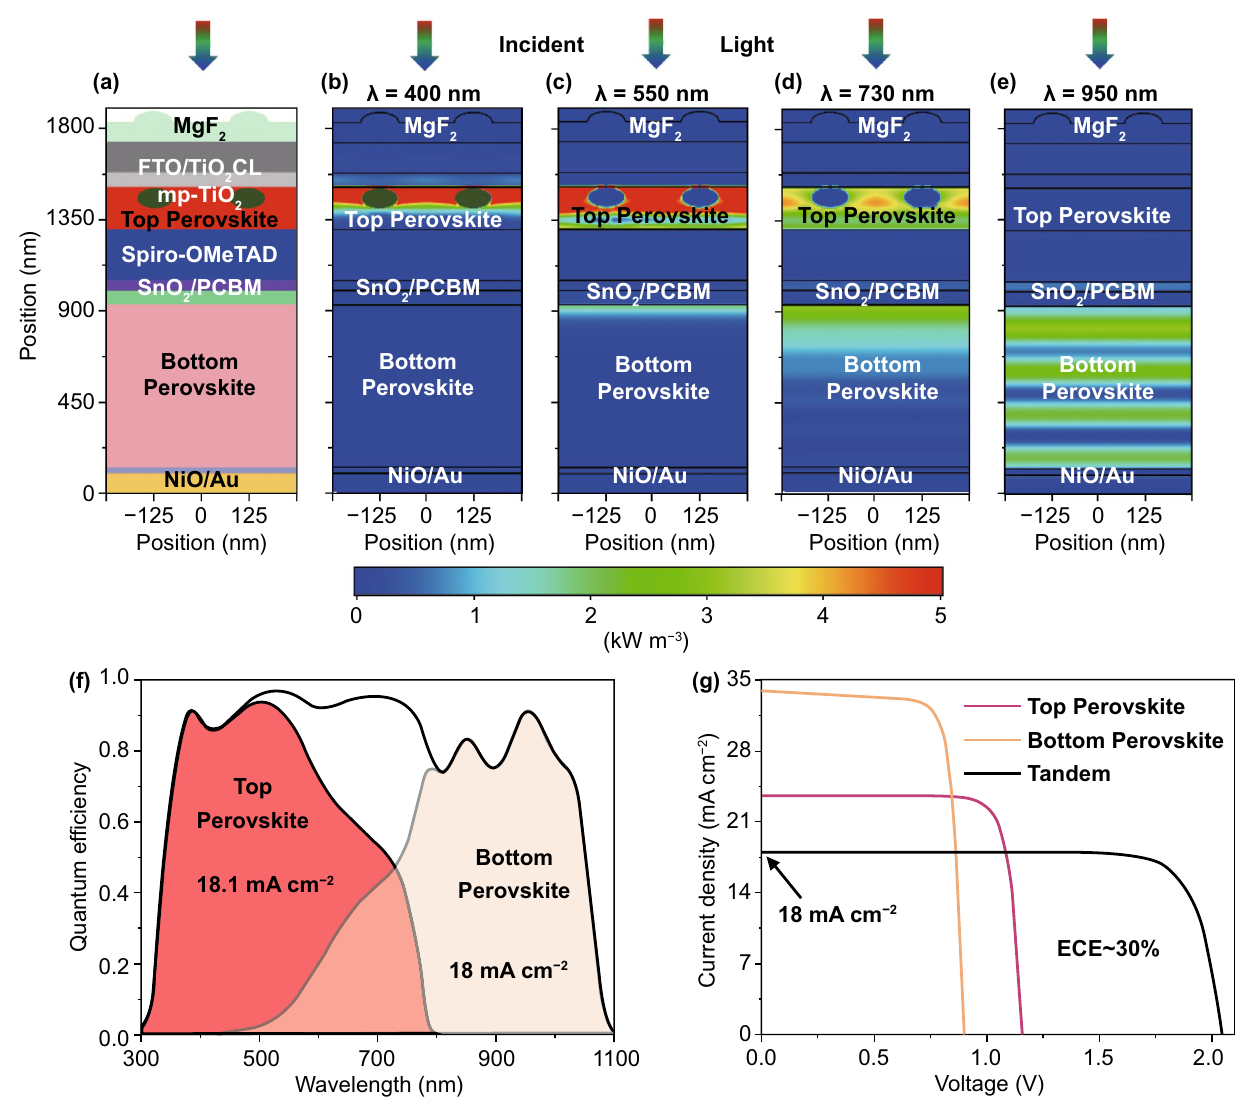
Fig. 7 a Schematic cross‑section of the optimized perovskite/perovskite tandem solar cell. Corresponding power density profile for an incident wavelength of b 400 nm, c 550 nm, d 730 nm, and e 950 nm. f Quantum efficiency and g current–voltage characteristic curves of the best‑inves‑ tigated perovskite/perovskite tandem solar cells under matching short‑circuit current condition, where top perovskite and bottom perovskite has a thickness of 210 and 800 nm,